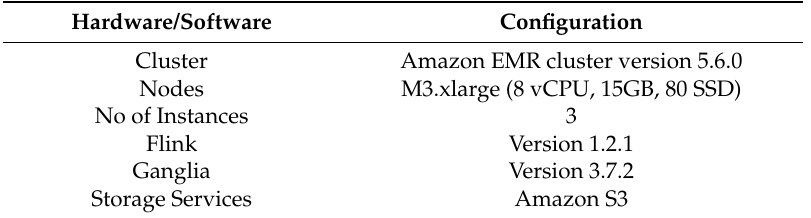
Table 2. Cluster configuration (adapted from